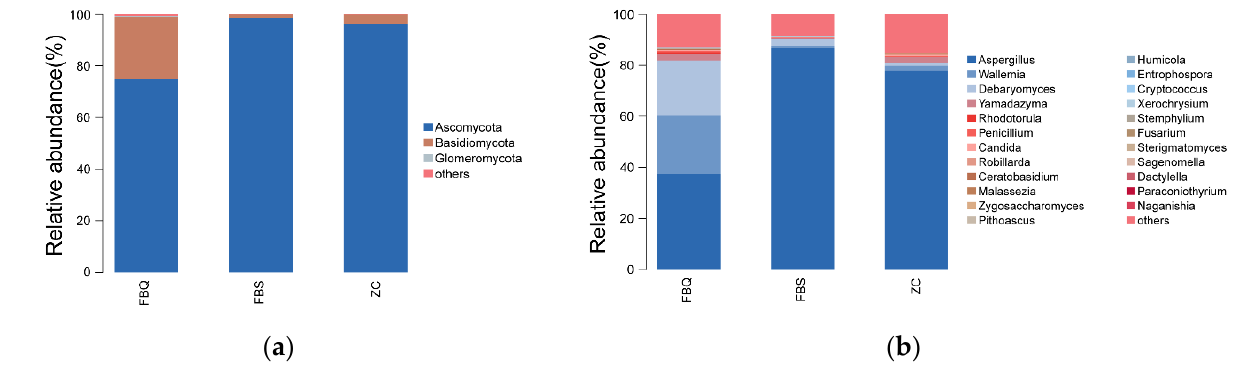
Figure 4. Relative abundance of fungal community proportions at the phylum ( a ) and genus ( b ) levels in Mianning ham. Different colors represent different fungal community and the size of the color area represents the relative abundance (percentage) of fungal community at the phylum ( a ) and genus ( b ).